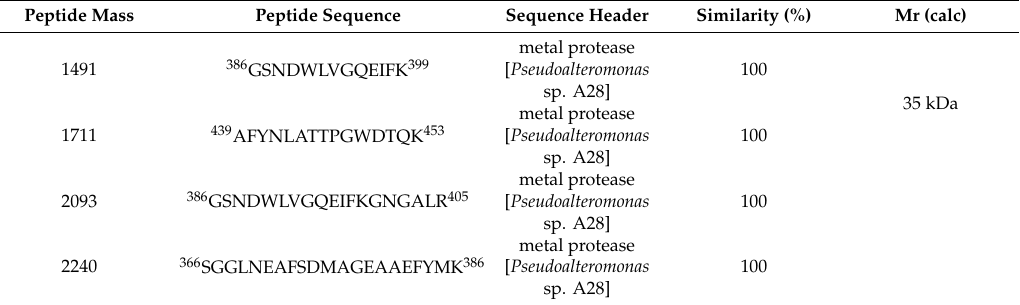
Table 3. Amino acid sequence of the protease by mass